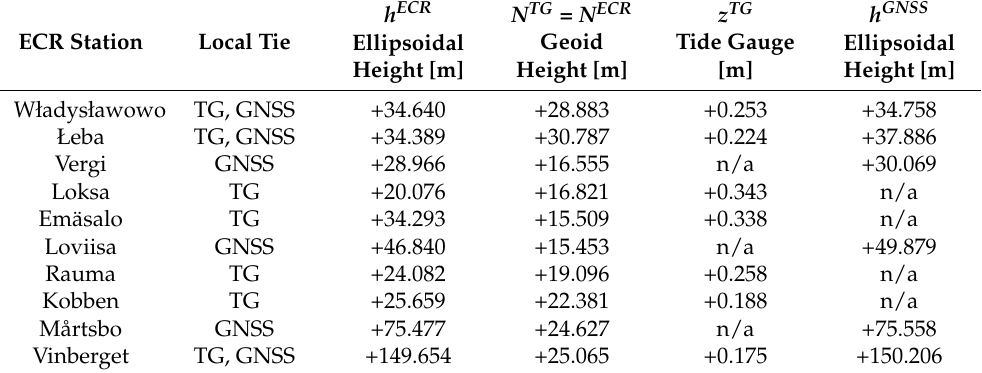
Table 9. Summary of observed ellipsoidal, geoid and TG heights at Baltic Sea network. All heights represent mean values averaged over the observation period in year 2020 or for epoch 2020.5. h ECR : ellipsoidal height of ECR reference point; N TG , N ECR : quasi-geoid height at location (same for tide gauge and ECR); z TG : TG sea level height above zero marker; h GNSS : ellipsoidal height of GNSS